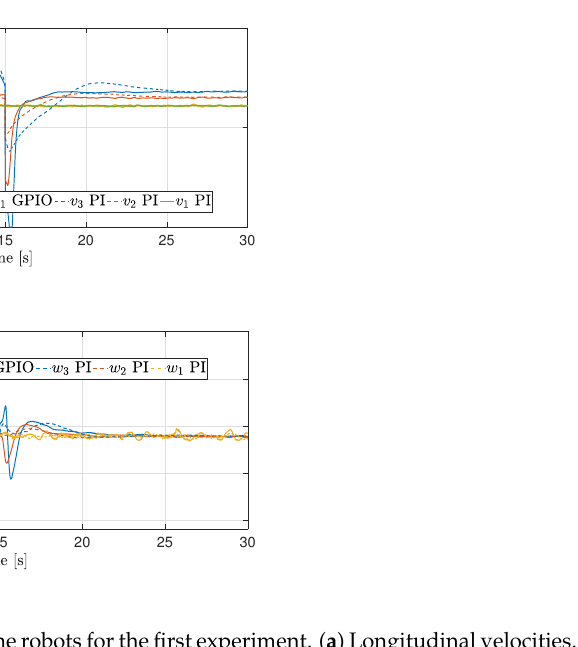
Figure 8. Control inputs for the robots for the first experiment. ( a ) Longitudinal velocities. ( b ) Angular velocities.